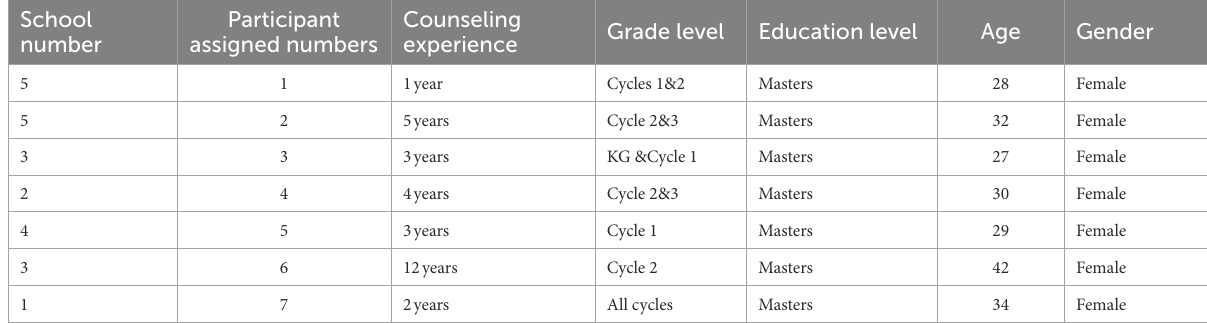
TABLE 1 Semi-structured interview participants’ demographic information.